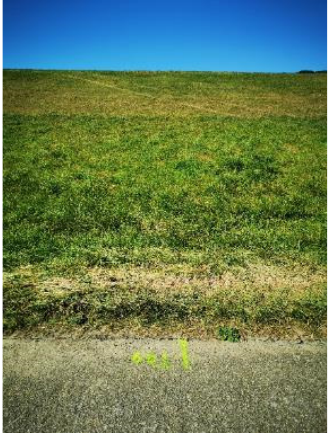
Figure 6. Dutch reference test section (September 2020).